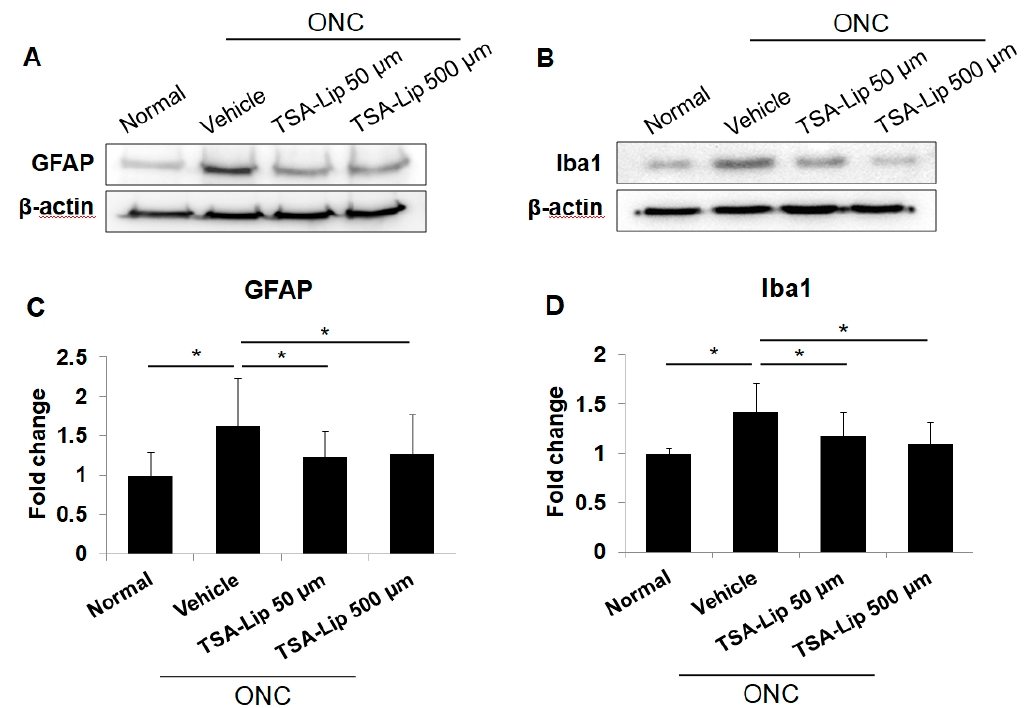
Figure 5. Effect of intravitreally injected TSA-loaded liposomes on gliosis in retina after optic nerve crush (ONC). The ONC procedure markedly increased GFAP ( A , C ) and Iba1 ( B , D ) protein expression in retinas at 3 days. The intravitreal injection of TSA-loaded liposomes significantly attenuated this response. The relative chemiluminescence intensity for each protein band was normalized using β -actin as a calibrator. TSA - Lip 50 μ M = liposomes loaded with 50 μ M TSA; TSA - Lip 500 μ M = liposomes loaded with 500 μ M TSA. Error bars represent the SD ( n = 6 retinas per group); * p < 0.05; one-way ANOVA with post-hoc LSD test.